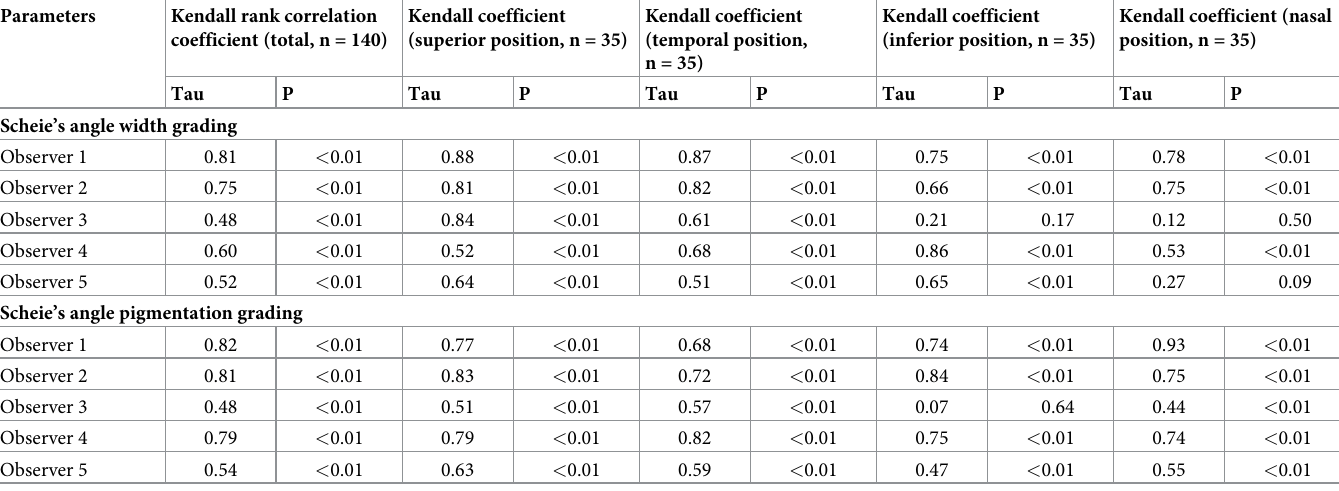
Observer 1, 2, 3 = glaucoma specialists.